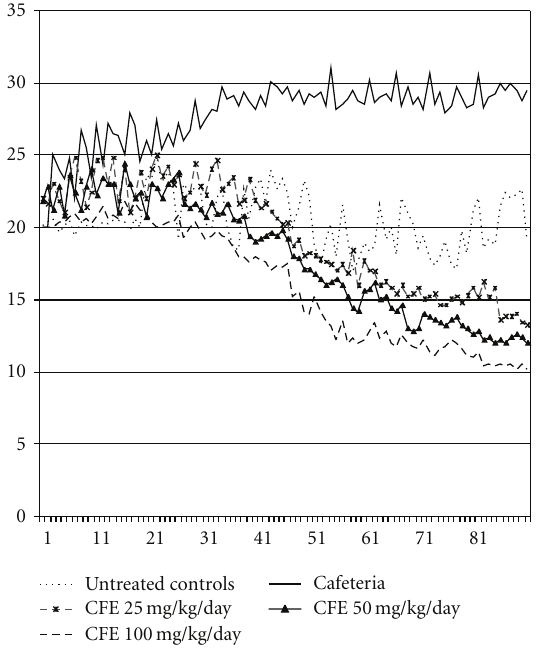
ff ect of CFE on rats’ body weight in gramsover 12 weeks. Figure 1: Feed intake in grams over 90 days. Figure 2: E was restricted to 110.79% (82 . 86 ± 1 . 73; P = . 025); at 100 mg/kg/day total cholesterol was e ff ectively normalized, at 102.01% (76 . 30 ± 1 . 29) with no statistical di ff erences between this group and the controls ( P = . 797).